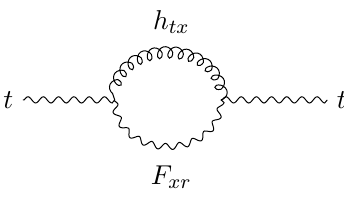
Figure 5 . Gravitational dressing to photon’s wave